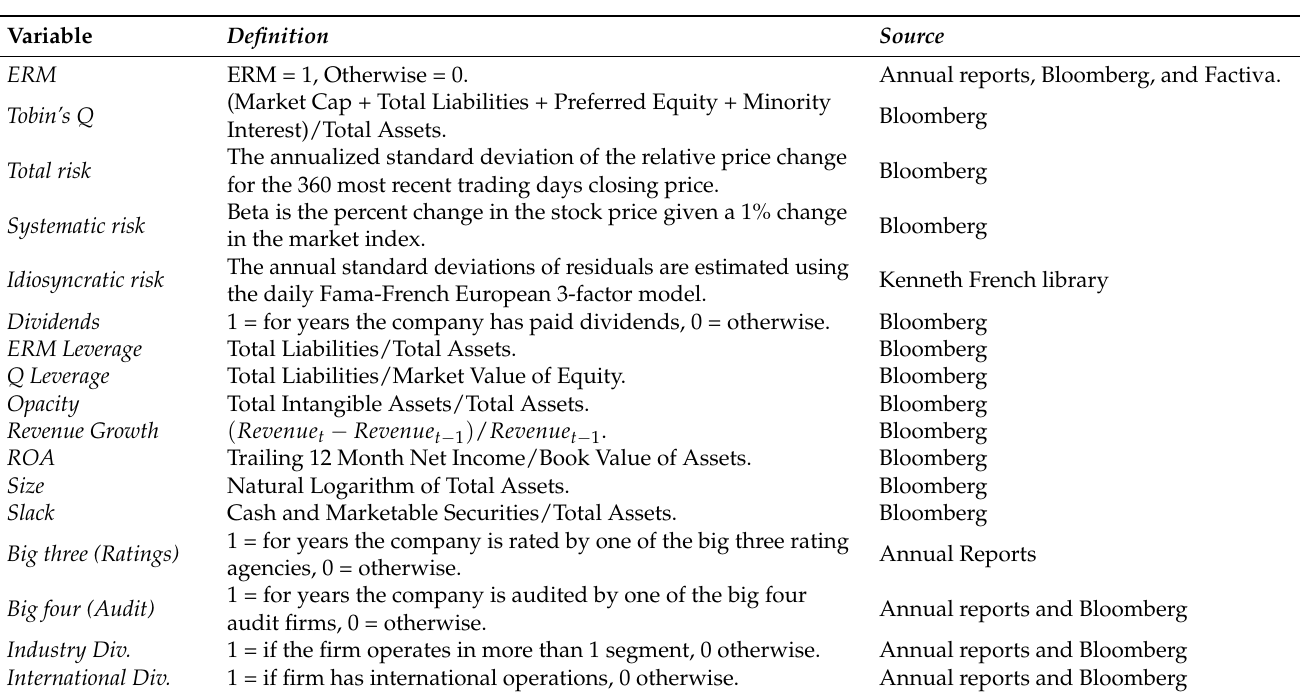
Table 1. Variable description.